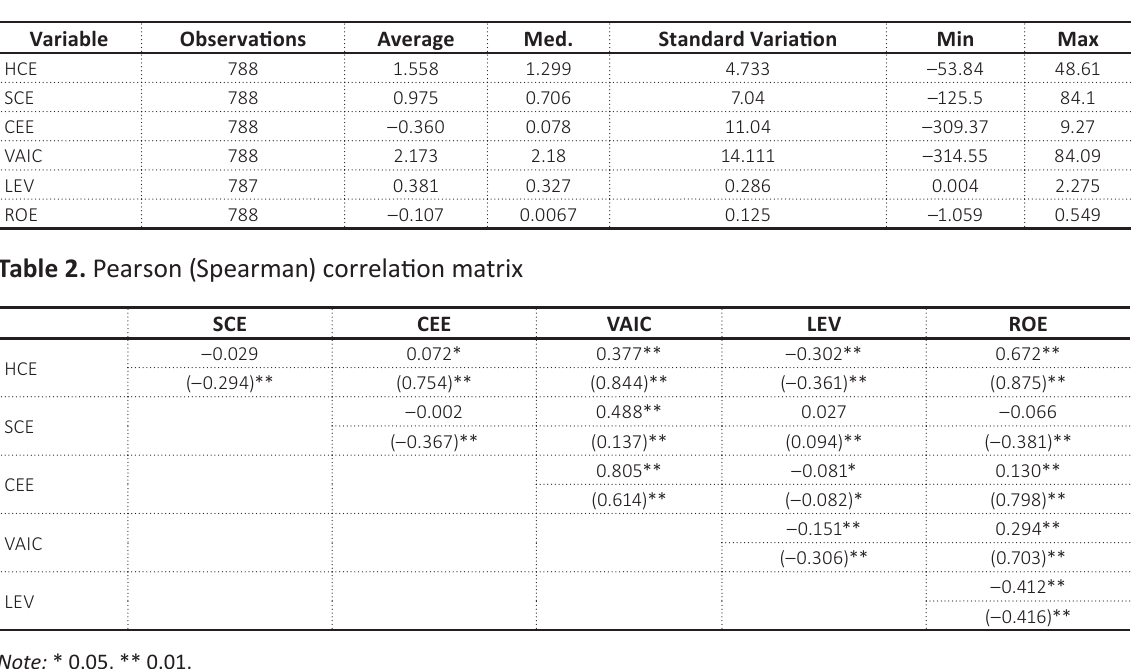
Table 1. Descriptive analysis